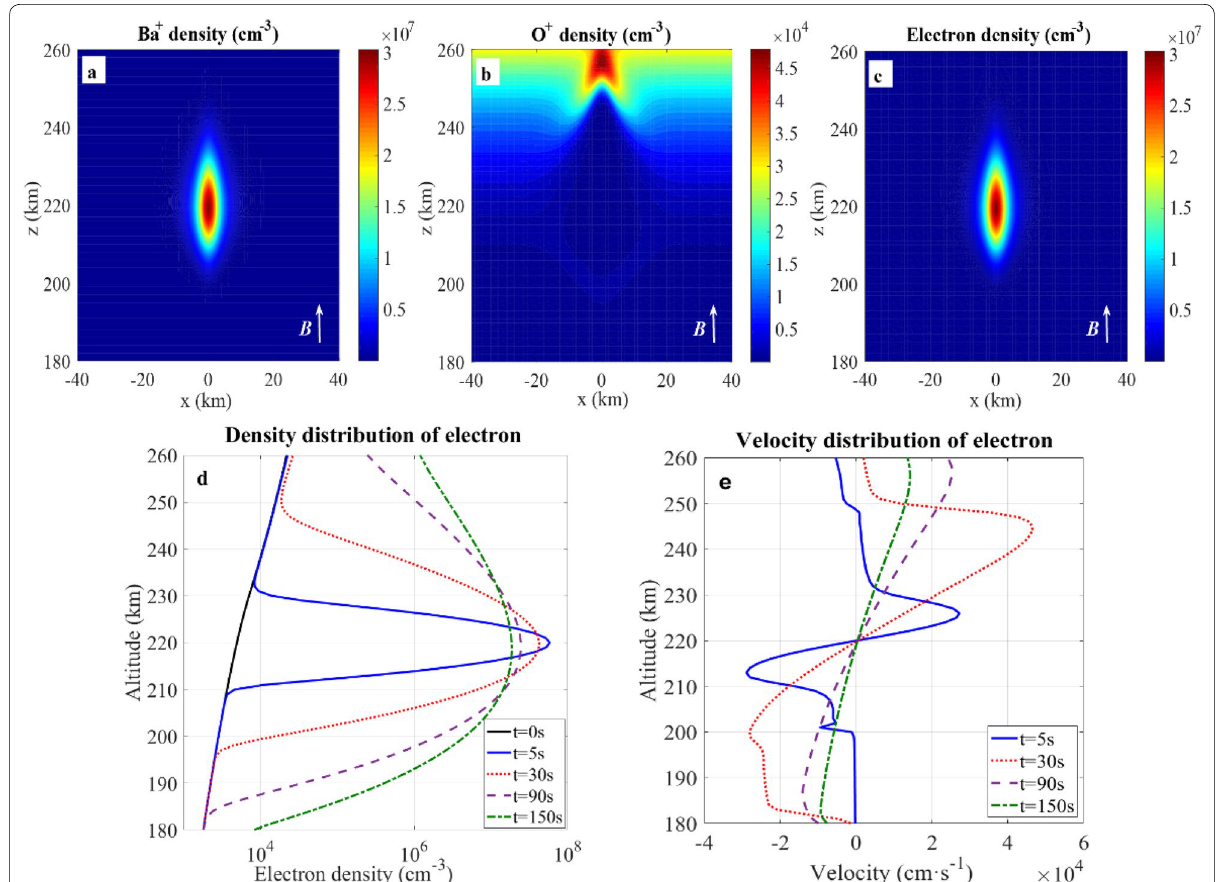
Fig. 3 The plasma cloud distribution in the x–z plane (at t distribution of electron density and velocity over height at different times ( d , e ). The maximum densities at t